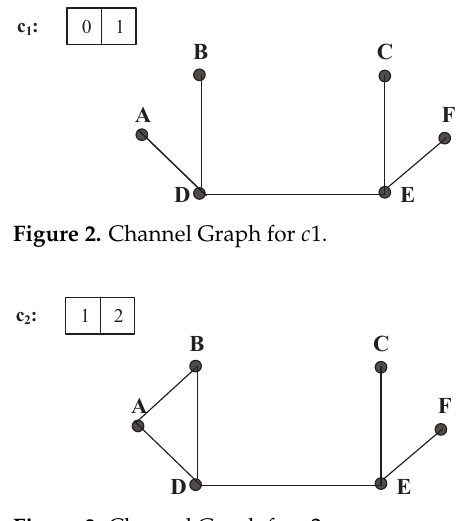
Figure 3. Channel Graph for c 2.